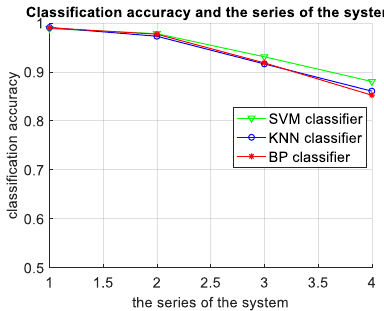
Figure 21. The relationship between classification accuracy and the series of the system based on the measured data.